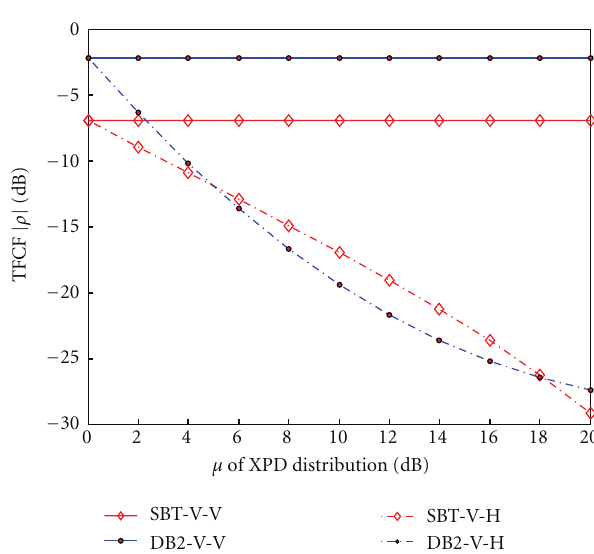
Figure 13: Normalized time-correlation functions of SBT and DB rays vary with the mean XPD μ and the configuration is set up in Table